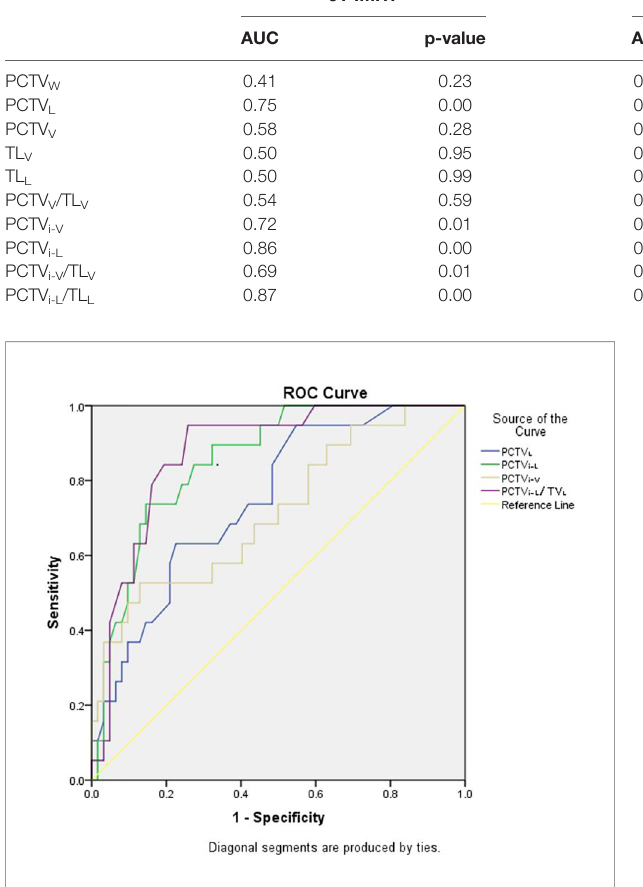
FIGURE 2 | ROC analysis curves of JT IMRT for PCTV L , PCTV i-V , PCTV i-L and PCTV i-L /TL L .